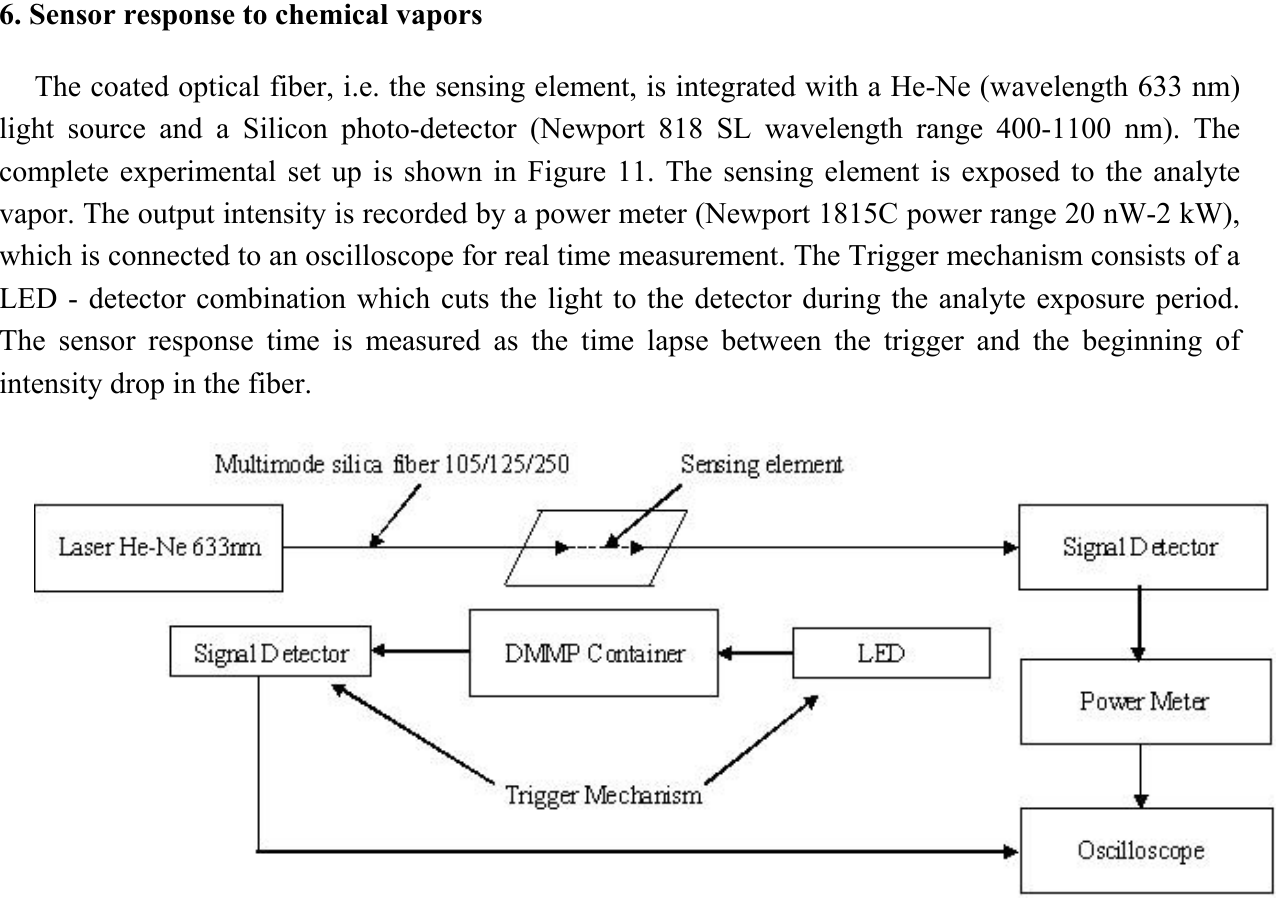
Figure 11. Experimental set-up for sensor